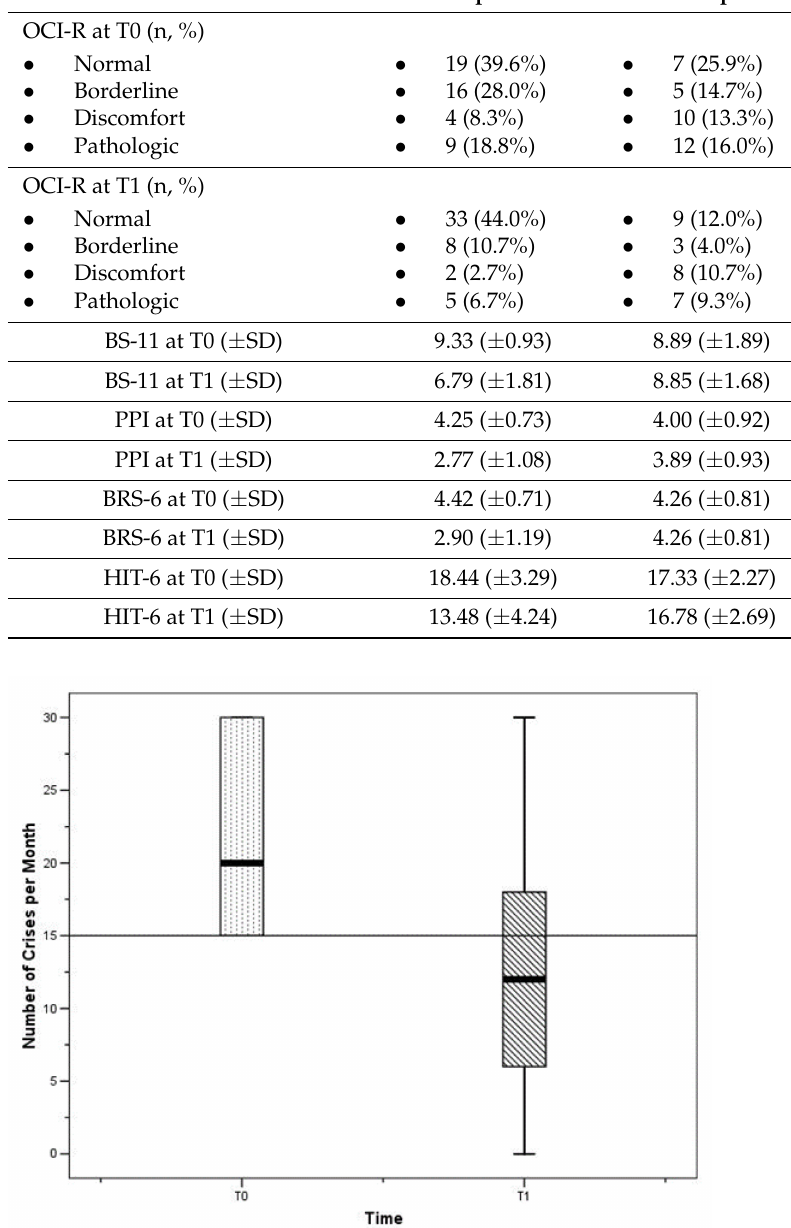
Figure 1. Differences between T0 and T1 in the monthly number of